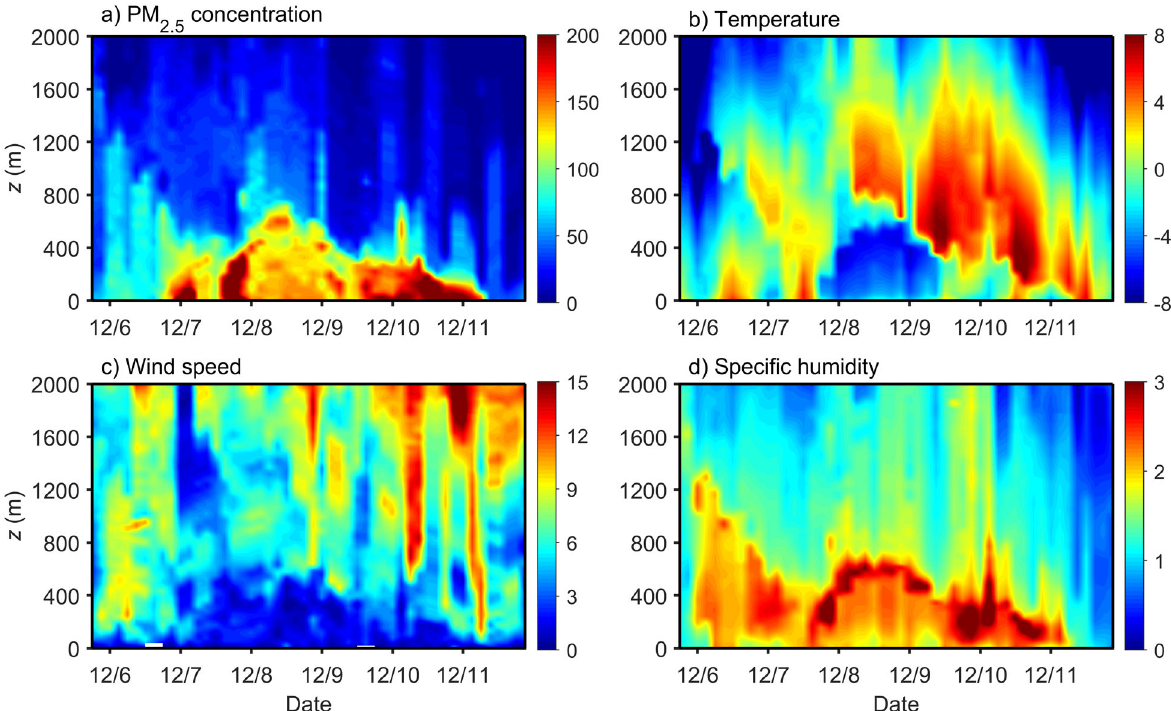
Fig. 4 Temporal variations of the vertical distributions of air pollutants and atmospheric boundary layer structure at Baoding station from 6 to 11 December 2019. a PM 2 : 5 concentration (unit: μ g m − 3 ), ( b ) temperature (unit: ˚ C), ( c ) wind speed (unit: ms − 1 ), and ( d ) speci fi c humidity (unit: g kg − 1 ).